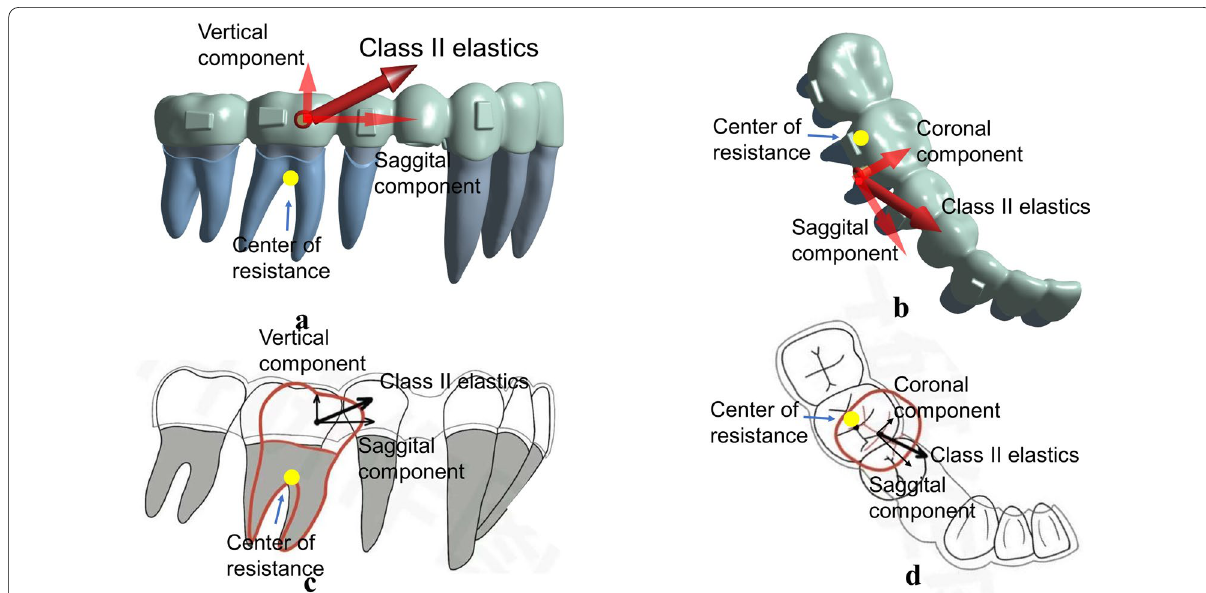
Fig. 11 Elastics localization was located on the buccal side of the center of resistance of the lower first molar ( a, b ) which would aggravate the mesial tipping ( c ), lingual tipping and mesiolingual rotation ( d ) of the posterior